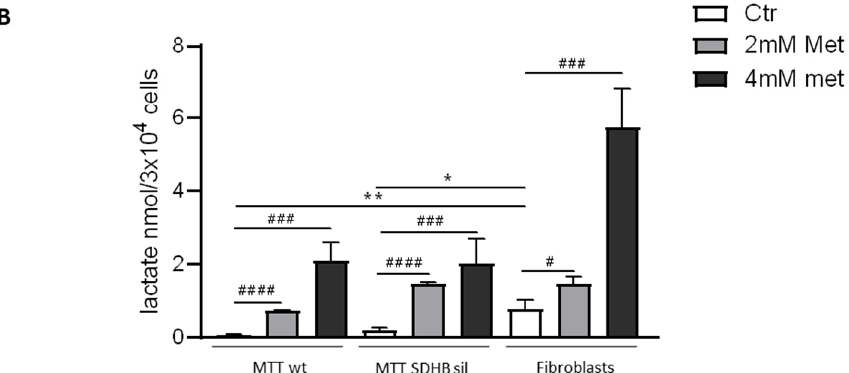
Figure 2. Effect of metformin on metabolic parameters. Intracellular ATP and lactate concentrations were measured in MTT wt, MTT SDHB sil and fibroblasts cells after 72 hours of 2 mM (light grey bars) or 4 mM metformin (dark grey bars) or 0 mM metformin (white bars) treatment and normalized on cell number. ( A ) A significative reduction of ATP level was detected in MTT wt and MTT SDHB sil cells, and in fibroblasts following both 2 and 4 mM of metformin treatment. The ATP basal levels in fibroblasts were significantly higher compared with both MTT cells (hashtags indicate the statistic of ATP values between treated and untreated cells, ## p < 0.01, ### p < 0.001, #### p < 0.001. Asterisks indicate the statistic of ATP values among the different untreated cell populations, **** p < 0.0001). ( B ) A significative increase in intracellular lactate level was observed in all the cell populations after metformin treatment with both 2 mM and 4 mM (hashtags indicate the statistic of lactate values between treated and untreated cells, # p < 0.05, ### p < 0.001, #### p < 0.001. Asterisks indicate the statistic of lactate values among the different untreated cell populations, * p < 0.05, ** p < 0.01). Bars of both ATP and lactate are the means of four independent experiments with two replicates each ± SD. Hashtags and asterisks indicate significance by one tailed paired t -test.